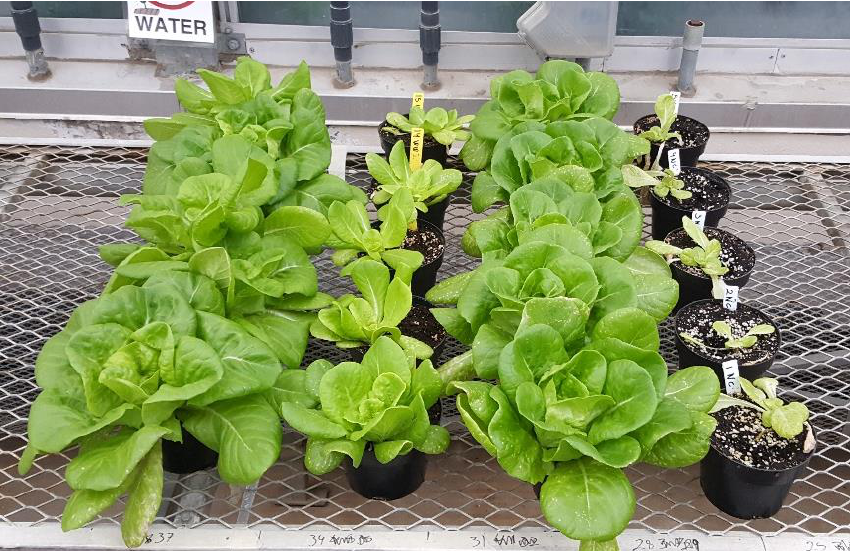
Figure 2. Image of ‘Salanova Green Butter’ lettuce plants (day 42) grown in University of Minnesota’s Plant Growth Facilities greenhouse (St. Paul, MN). Plants were grouped by fertility treatment in rows; from left to right: digested wastewater, raw wastewater, inorganic fertilizer, and no fertilizer.